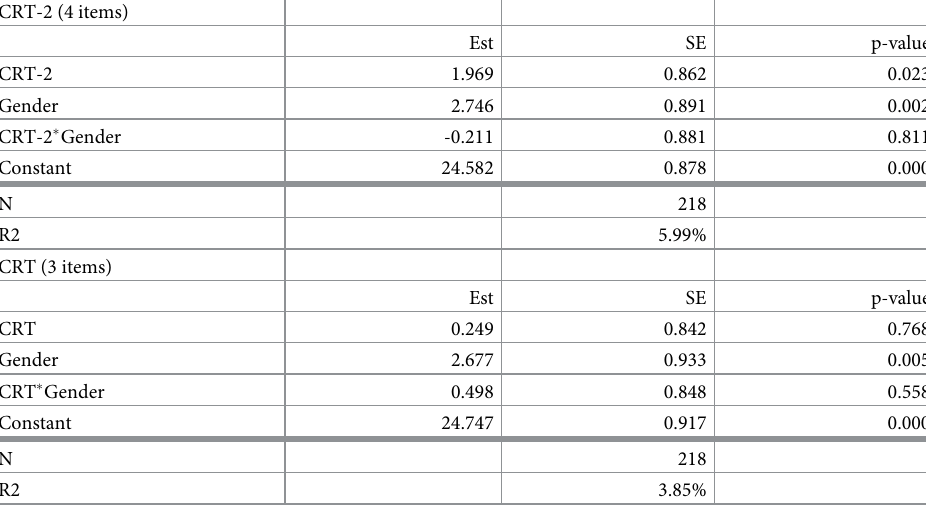
Table 4. Social value orientation as a function of cognitive reflection and